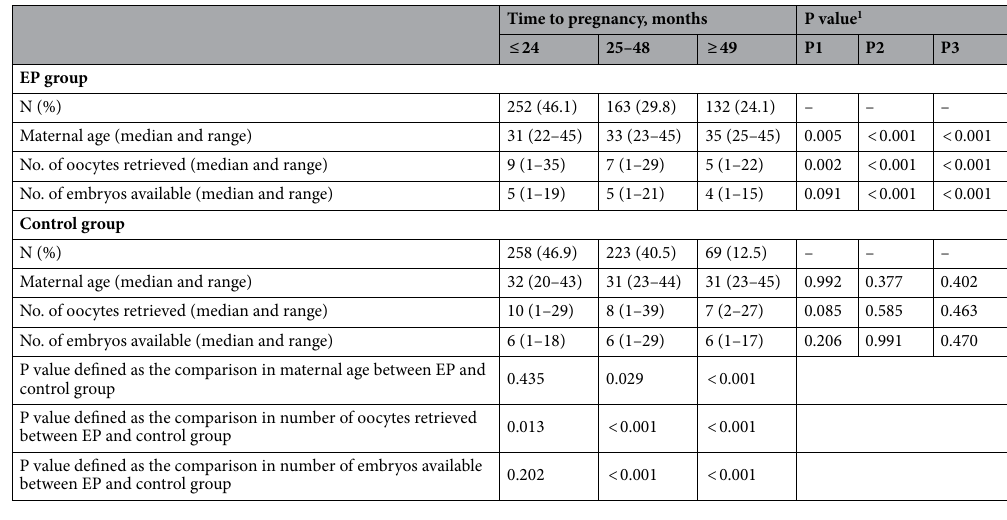
Table 2. Maternal age, the number of oocytes retrieved and embryos available in both two groups, stratified by time to pregnancy. 1 We defined the statistical outcomes of ≤ 24 months group versus 25–48 months group as